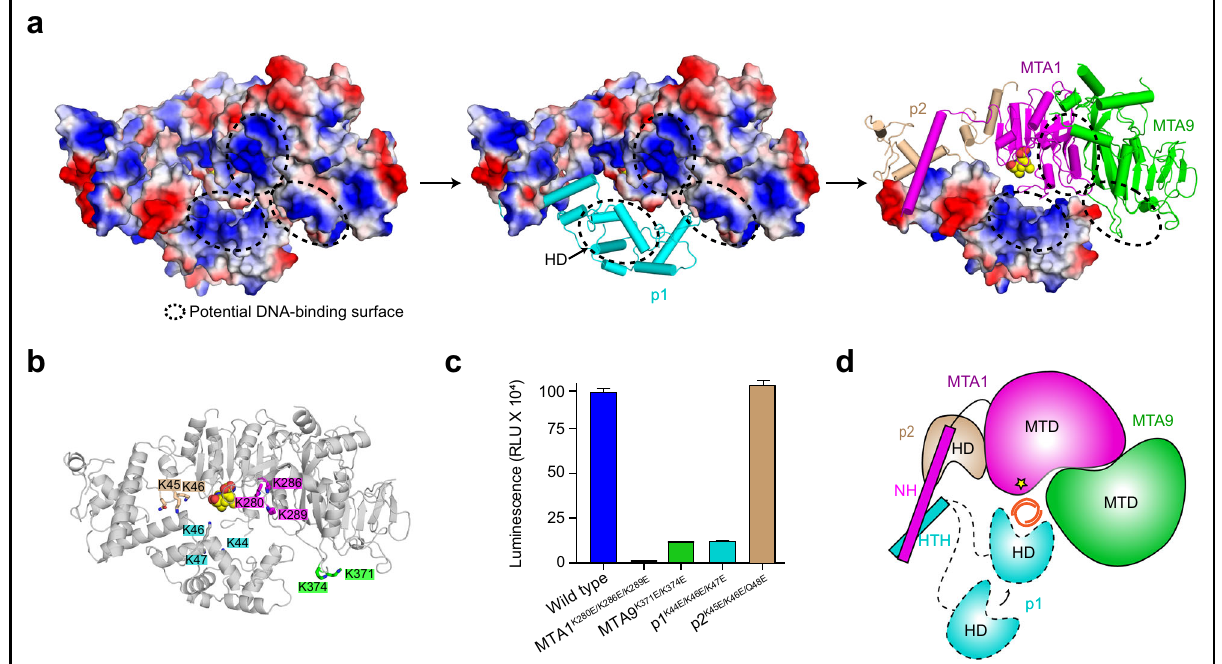
Fig. 5 Potential DNA-binding surfaces in the MTA1 complex. a The surface electrostatic potential of the MTA1 complex calculated by PyMOL. Three potential DNA-binding surfaces between MTA1 (magenta), MTA9 (green), and p1 (cyan) are highlighted by black dashed ellipses. SAM is illustrated as a yellow space- fi lling representation. HD, homeobox-like domain. b The positively charged residues in the potential DNA-binding surfaces of MTA1, MTA9, p1, and p2 are shown in magenta, green, cyan, and wheat rectangles, respectively. c The MTase activities of the wild-type MTA1 complex and the mutant complexes with mutations in the putative DNA-binding surfaces. The indicated mutations were introduced to each of the four subunits: MTA1, K280E/K286E/K289E; MTA9, K371E/K374E; p1, K44E/K46E/K47E; p2, K45E/K46E/Q48E. The error bars indicate the SEM of three independent measurements. The experiment was repeated twice. d The proposed working model for DNA 6mA modi fi cation by the MTA1 complex. MTA1 (magenta) primarily functions as a catalytic core. MTA9 (green) and p1 (cyan) facilitate DNA binding and p2 (wheat) help stabilize the MTA1. The DNA substrate (orange ribbon) is coordinated by MTA1, MTA9, and p1. The p1 HD and HTH are connected by a fl exible loop. SAM is indicated as a yellow star. NH, N-terminal helix; HTH, helix-turn-helix-like motif; MTD, MTase